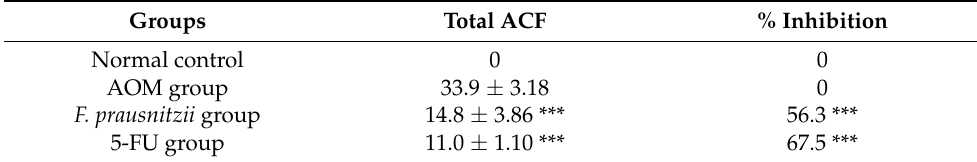
Table 1. Aberrant crypt foci (ACF) count in treated and untreated groups. Groups Total ACF % Inhibition Normal control